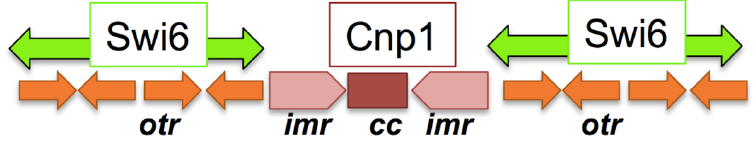
Figure 1. S. pombe centromere organization, in which heterochromatin protein Swi6 binds in the outer repeats flanking a central core with the centromere-specific histone Cnp1.